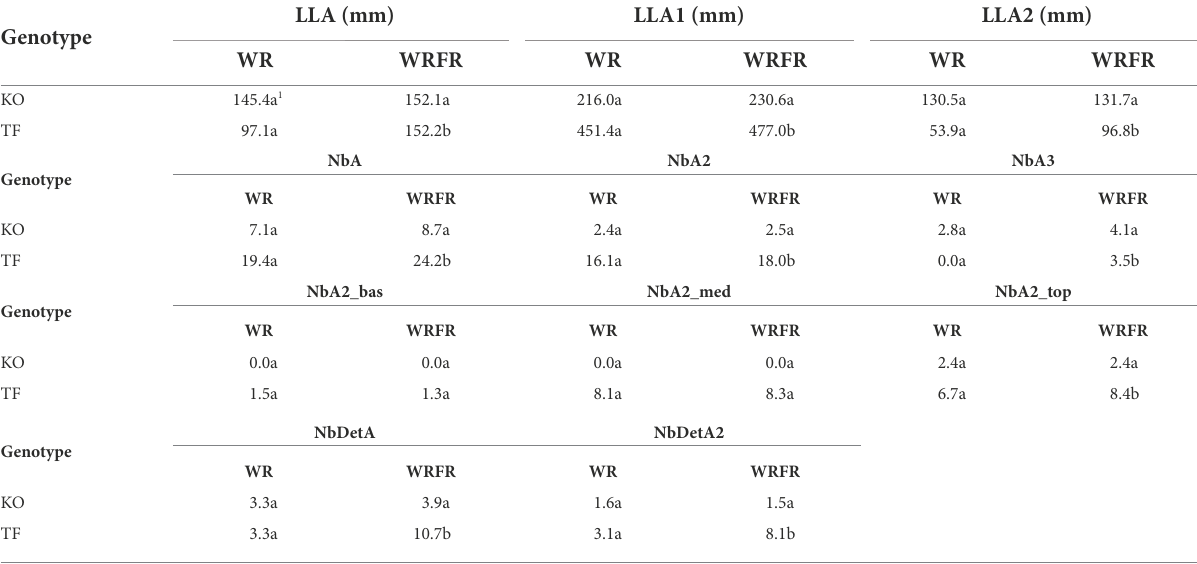
TABLE 3 Least-square means (LS means) of elongation, branching and flowering variables measured at the ‘VFB of the order 2 axes carried by the order 1 long axis in apical position’ stage for Knock Out ® Radrazz (KO) and ‘The Fairy’ (TF) grown in a climate chamber under two light conditions: WR and WRFR.